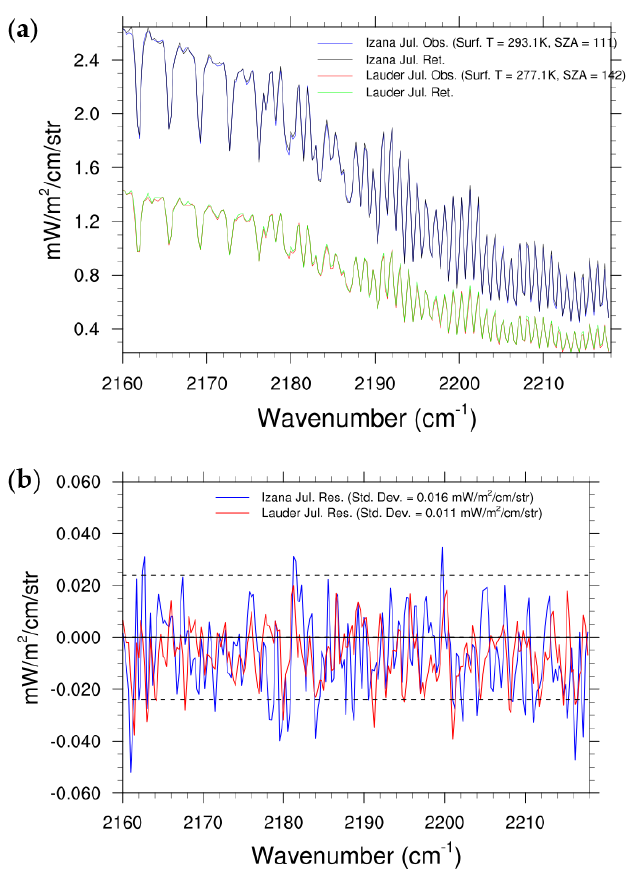
Figure 2. Example of spectral fits in the N 2 O window: ( a ) observed (IASI) and fitted radiances for Izana and Lauder in July, ( b ) observed minus fitted radiances (residuals). The dashed horizontal lines indicate the noise level from Hilton et al.